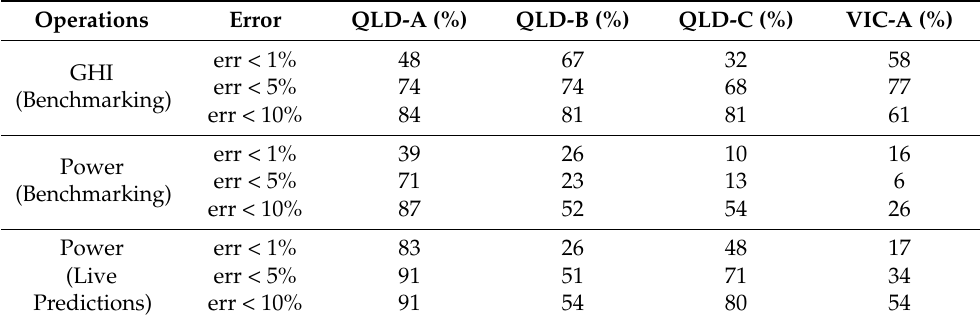
Table 10. Percentage of days where SIFM outperforms simple persistence forecasts for the bench- marking and live